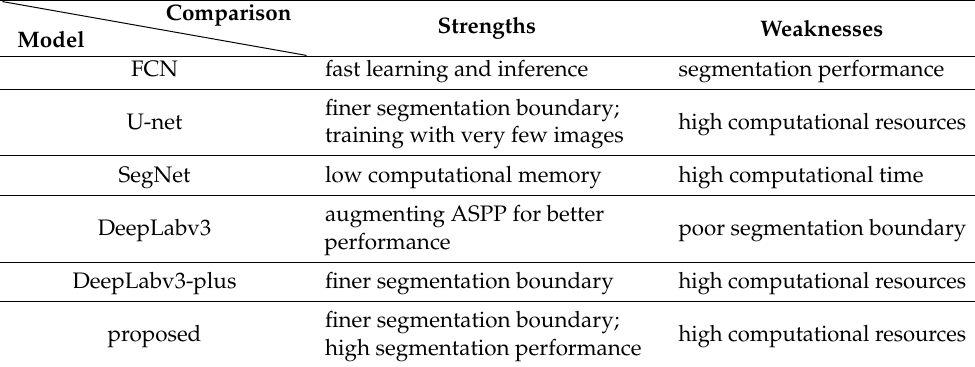
Table 2. Comparison of related works and proposed model.